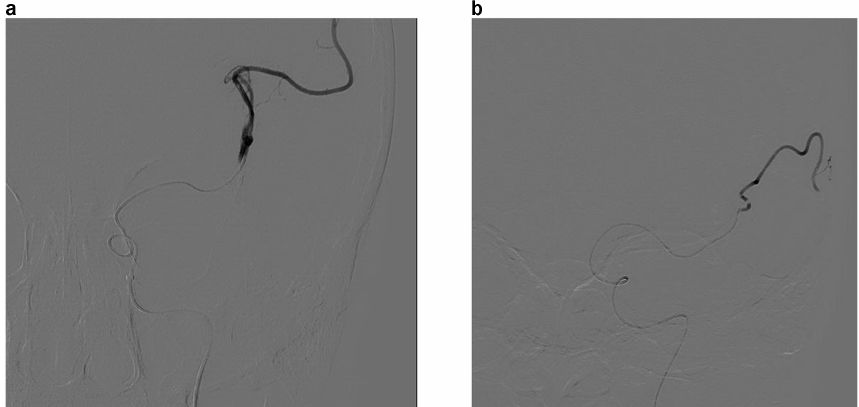
Figure 1. (a) Determination of superior branch by microcatheter injection. (b) Determination of inferior branch by microcatheter